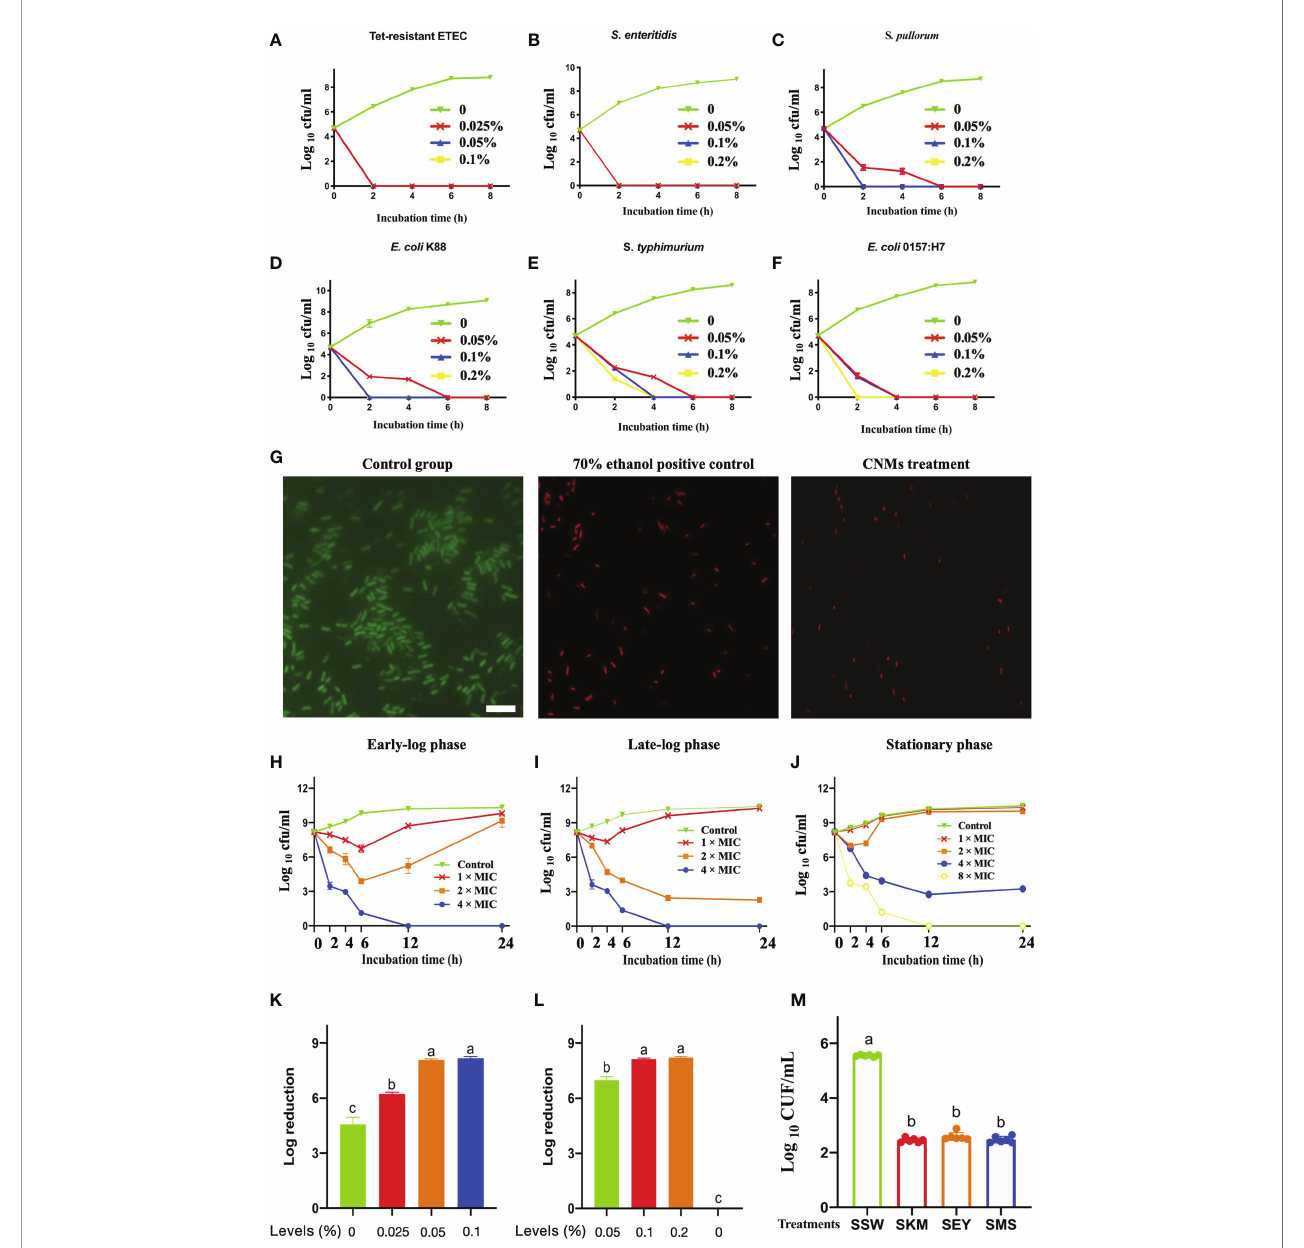
FIGURE 1 | Comprehensive evaluation of antimicrobial activity ofCNMs. Different indicated bacterialsat approximately 5 × 10 4 cfu/ml were cultured with differentindicated concentrationsofCNMsfor various durations. After incubation,the concentration of bacteriawas measured by counting the number of colonies. (A – F) Time-killing kinetics of different concentrationsof CNMs toward pathogenic bacteria. (A) Tet-resistant ETEC: tetracycline-resistant enterotoxigenic Escherichia coli. (B) S. enteritidis: Salmonella enteritidis , (C) S. pullorum:Salmonella pullorum , (D) Escherichia coli K88, (E) S. typhimurium:Salmonella typhimurium , and (F) Escherichia coli O157. Data are presented three independent experiments. (G) The engineered CNMskilltetracycline-resistant ETEC. Live/dead viability analysisof tetracycline-resistant ETEC challenged. Fluorescent micrographs ofcells treated with 0% CNMs areshownonthe left, 70% ethanolis shownin the middle, orCNM at the 1 × MIC level isshown on the right. The white bar indicates 6 µm. (H – J) Bactericidal activity of CNMsagainst Tet-resistant ETEC. The indicated bacteriawere incubatedin early-log (B) , late-log (C) ,and stationary (D) phases. Approximately 5 × 10 8 cfu/ml Tet-resistant ETEC cells were cultured with CNMsat various concentrations. Data are presented three independent experiments. (K – M) Bactericidalactivity of CNMs at different concentrationsin syntheticgastrointestinal fl uidsand foodbiological products. Approximately5 × 10 8 cfu/mlTet-resistant ETEC was inoculated into fl uidscontaining CNMs. (K) Log reduction of bacteria after 1 h inSGF (pH= 2). (L) Log reduction of bacteria inSIF-containing CNMs. (M) Antibacterial activity of CNMs against Tet-resistant ETEC infood biological products. Approximately 5 × 10 6 cfu/ml of the indicated bacteriawas inoculatedinto autoclavedskimmilk(SKM), mincemeat supernatant (SMS),and sterilized egg yolk(SEY). Bacteria were treatedafter 2 h in bioenvironments containing 8 × MIC CNMs. Viablecells were counted. Data are indicatedas the mean cfu/ml ± standard error for three individual experiments. Meanswith different lowercase lettersdiffer ( p <